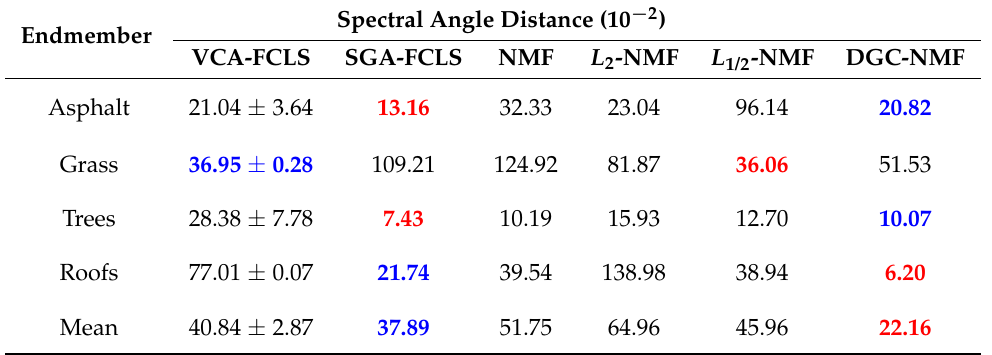
Table 2. The spectral angle distance and their standard deviations of algorithms on the urban dataset. Numbers in bold and red color represent the best results, numbers in bold and blue color represent the second-best results. FCLS: full constrained least squares.